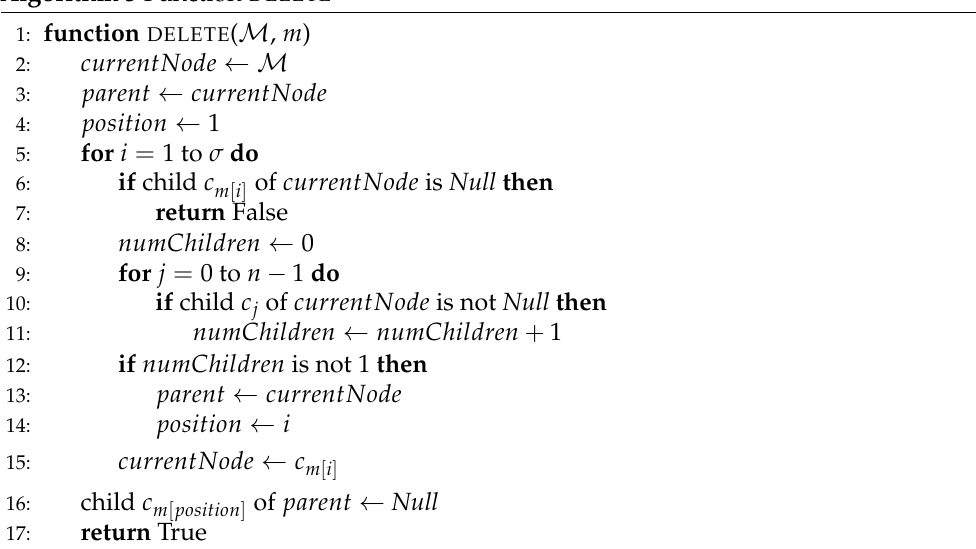
Algorithm 3 Function DELETE